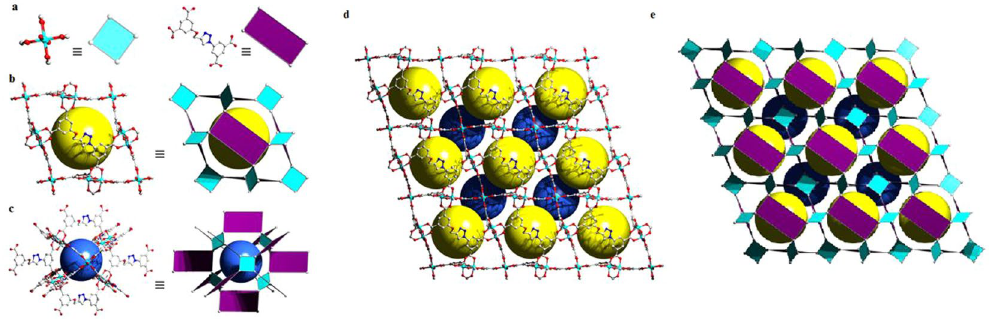
Figure 5. Representation of ( A ) the square Cu 2 (CO 2 ) 4 SBU’s and rectangular L 4 − - SBU’s; two different polyhedral pores ( B ) and ( C ) along with the polyhedral packing of these pores in the 3D framework of Cu-MOF ( D ) and ( E ) with yellow and blue spheres embody the spheres occupying the cavities, taking into account the interior VDW radii. Hydrogen atoms are omitted for